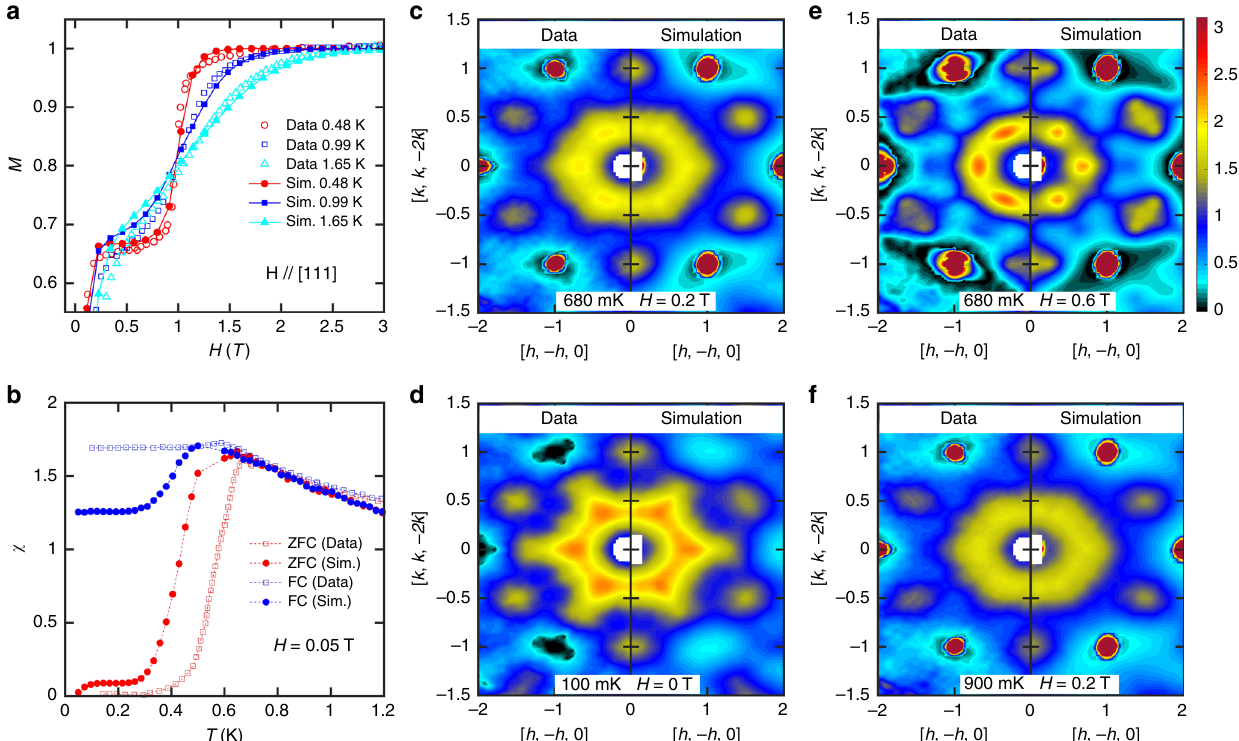
Fig. 5 Validation of the optimal solution over multiple experiments. a Magnetization as a function of magnetic fi eld and temperature, b zero- fi eld cooled (ZFC) – fi eld cooled (FC) susceptibility, c – f magnetic diffuse scattering measured at different temperature and magnetic fi eld combinations: [680 mK, 0.2 T], [100 mK, 0 T], [680 mK, 0.6 T] and [900 mK, 0.2 T] respectively. All the experiments and simulations shown here are done under magnetic fi eld along the [1,1,1] direction. The magnetization and the ZFC-FC data are extracted from refs. [5,26 ,